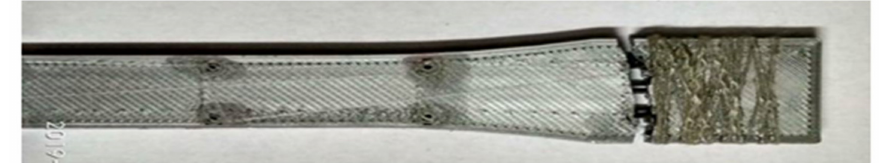
Figure 7. Tensile specimen of the CF rod reinforced PLA (CFRPLA) rod.